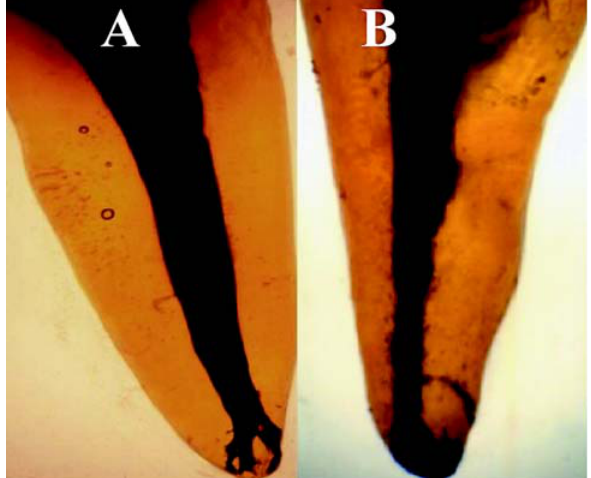
FIGURE 1- (A) Apical delta filled with AH Plus sealer observed in Group I (no EDTA). (B) Secundary canal filled with AH Plus sealer after irrigation with EDTA (Group II)